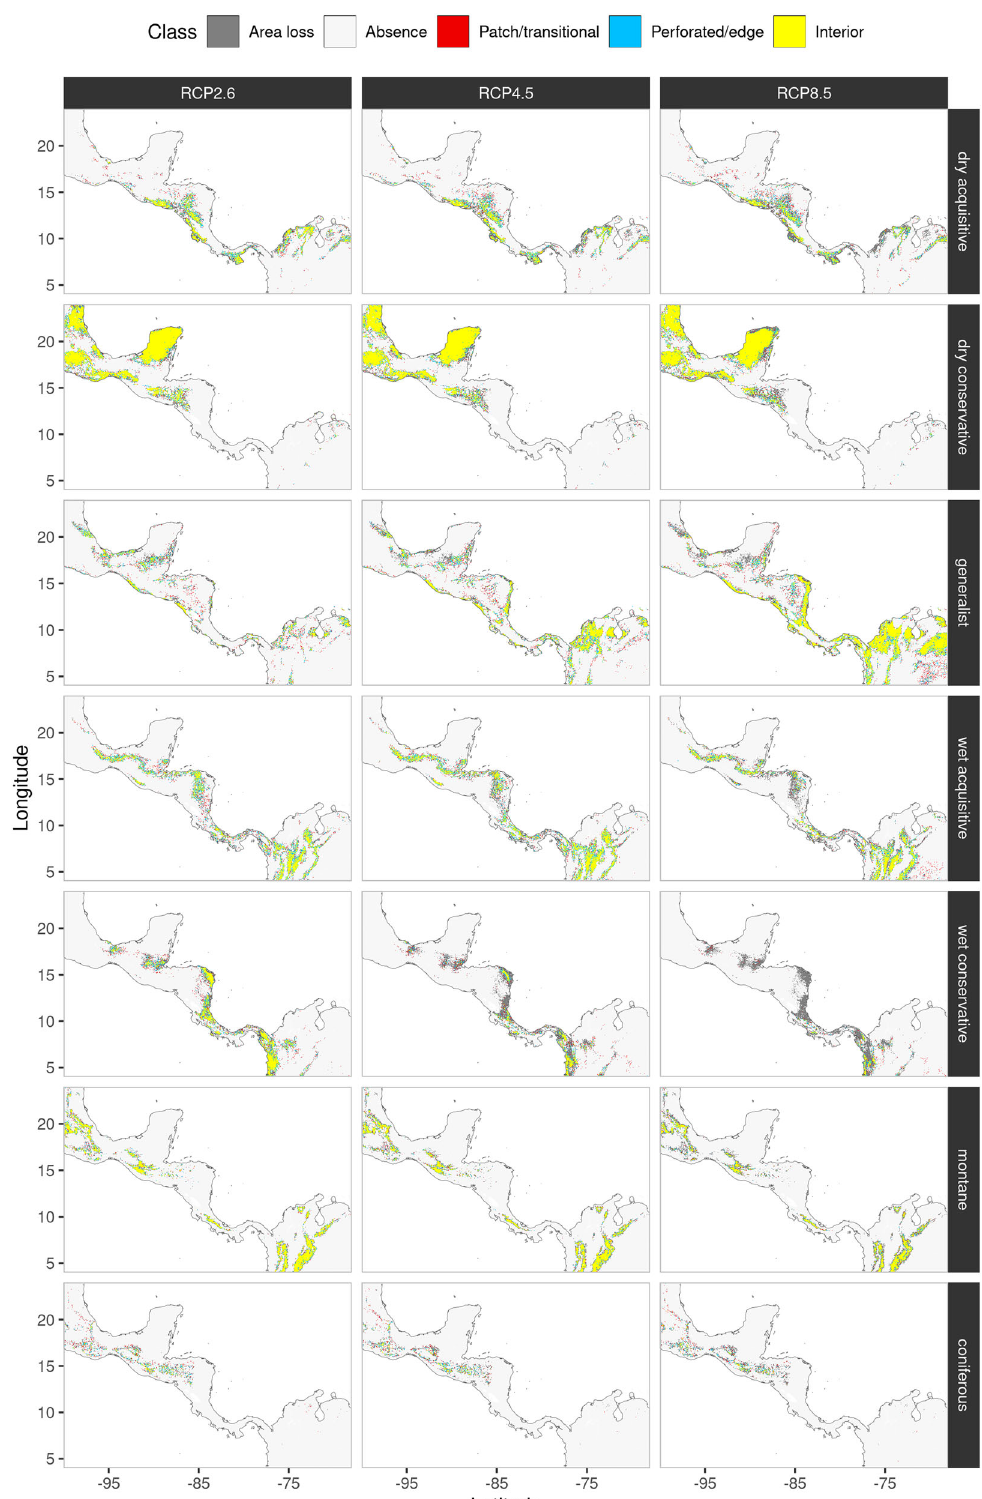
Fig. 3 PFT fragmentation. Maps showing fragmentation classes for each PFT in the areas where they were predicted as dominant (CCSM4 scenarios). Dark grey marks areas, which were covered by the PFT in present-day projections, but disappeared in the scenarios ( “ Area loss ” ). For de fi nitions of the other fragmentation classes see Methods